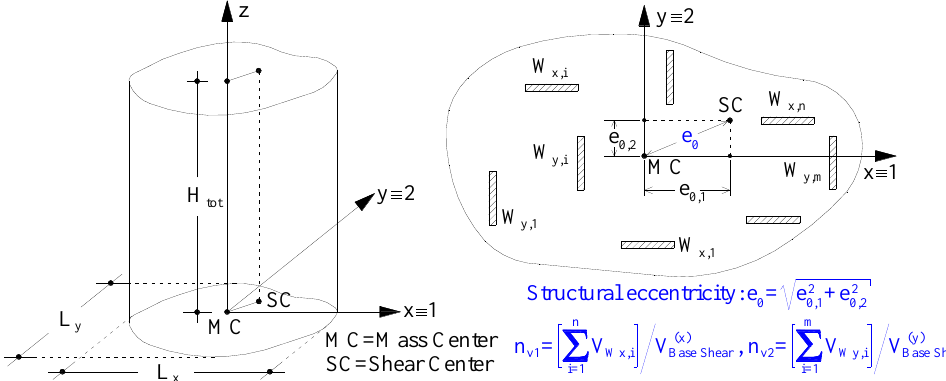
Figure 14. Description of the structural parameters imported to the input vectors of the trained MFPNNs.